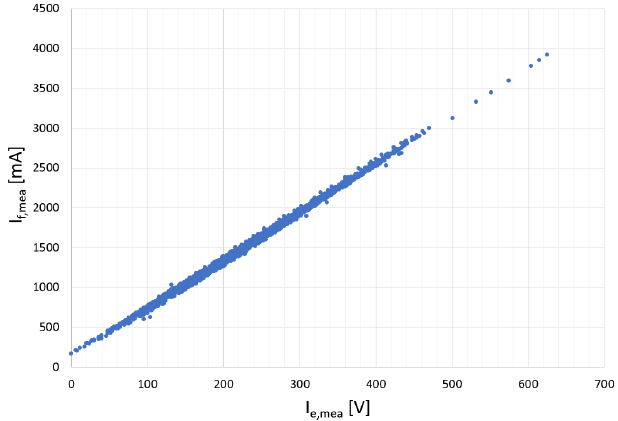
Figure 14. Experimental results. The relationship between the measured main machine field current ( I f,mea ) and the measured exciter field current ( I e,mea ) for all the experimental healthy condition tests.